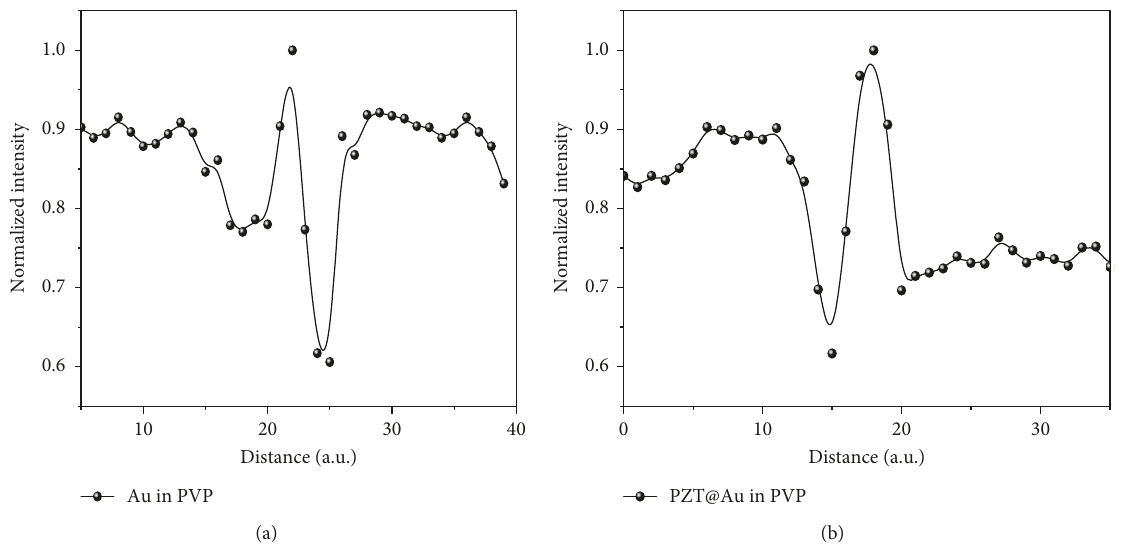
Figure 8: Transmittance with closed-aperture Z-scan of Au NPs and PZT@Au core-shell NPs in PVP solution.